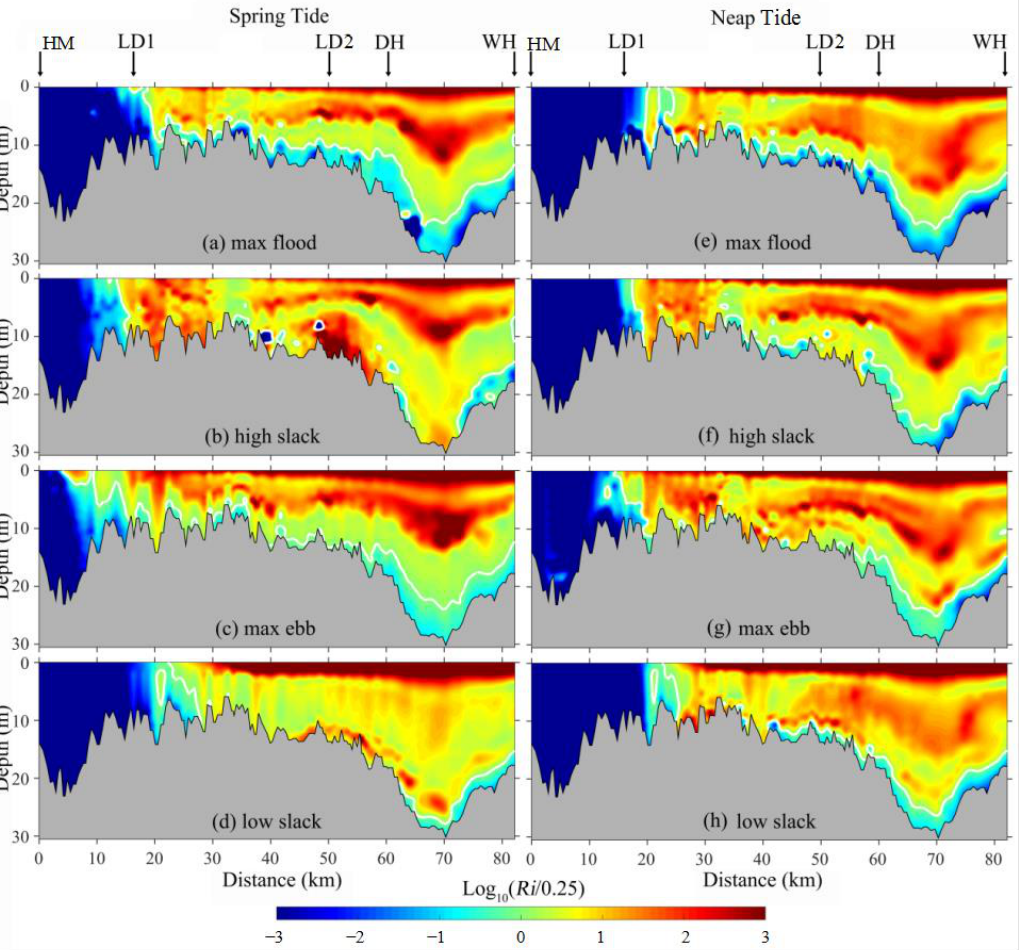
Figure 11. Longitudinal distributions of the gradient Richardson number log 10 ( Ri /0.25) along the channel (from stations HM to WH) at the West Channel in the Pearl River Estuary on a spring tide (left panels) and a neap tide (right panels) in the wet season. Note the value zero is denoted by a white solid line.